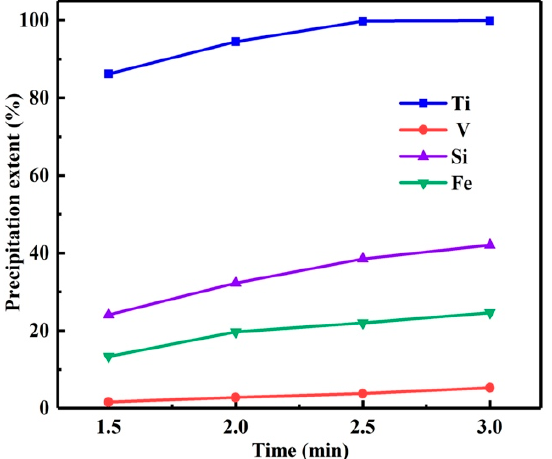
Figure 5. Influence of reaction time on precipitation extents.